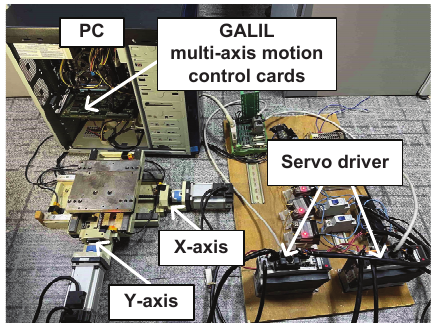
Figure 5. Experimental